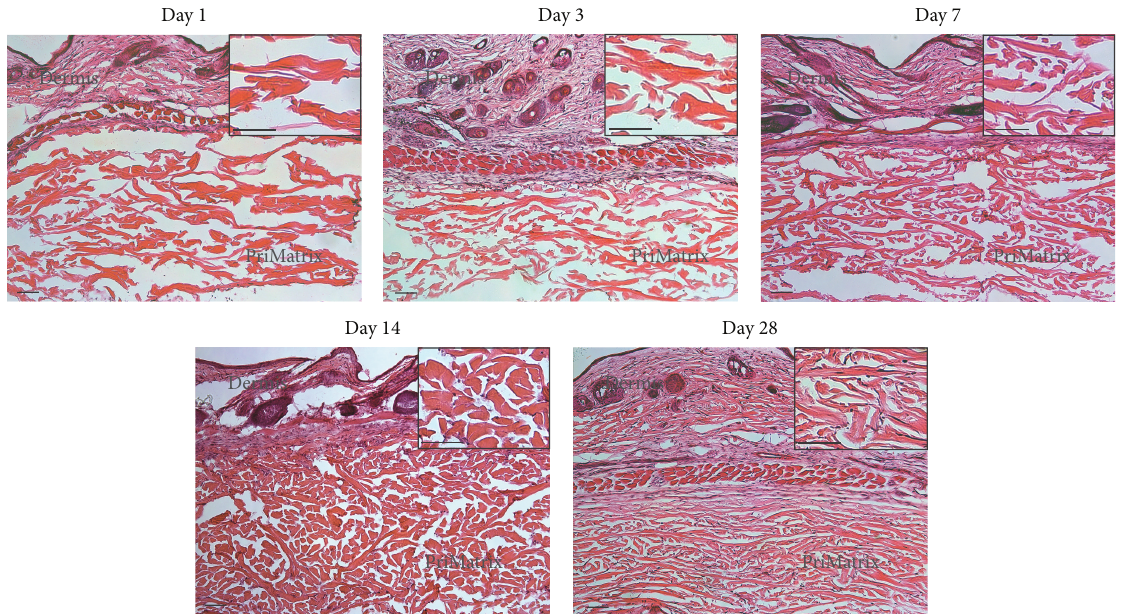
Figure 2: H&E staining of PriMatrix implants and overlying dermis at days 1, 3, 7, 14, and 28 following implantation (with insets of higher powerimagesofimplant).Aprogressivecellularinfiltrateisseenpopulatingtheimplantfromtheperiphery,withtheimplantbeingremodeled to resemble the overlying dermis by day 28. At this time point, the transition from implant to native tissue is indistinct, with minimal fibrotic capsule formation noted. Scale bar is 100 𝜇 m for all